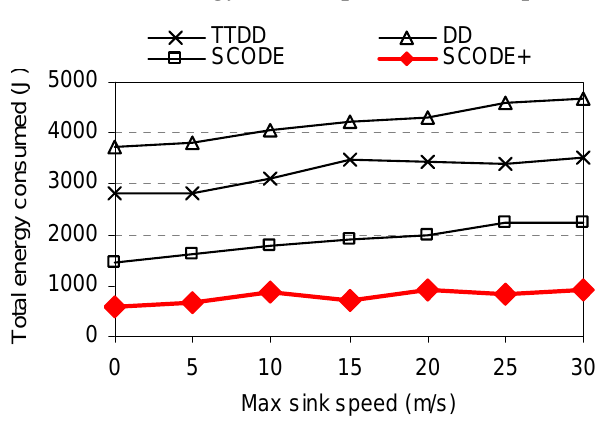
Figure 12. Energy consumption vs. sink